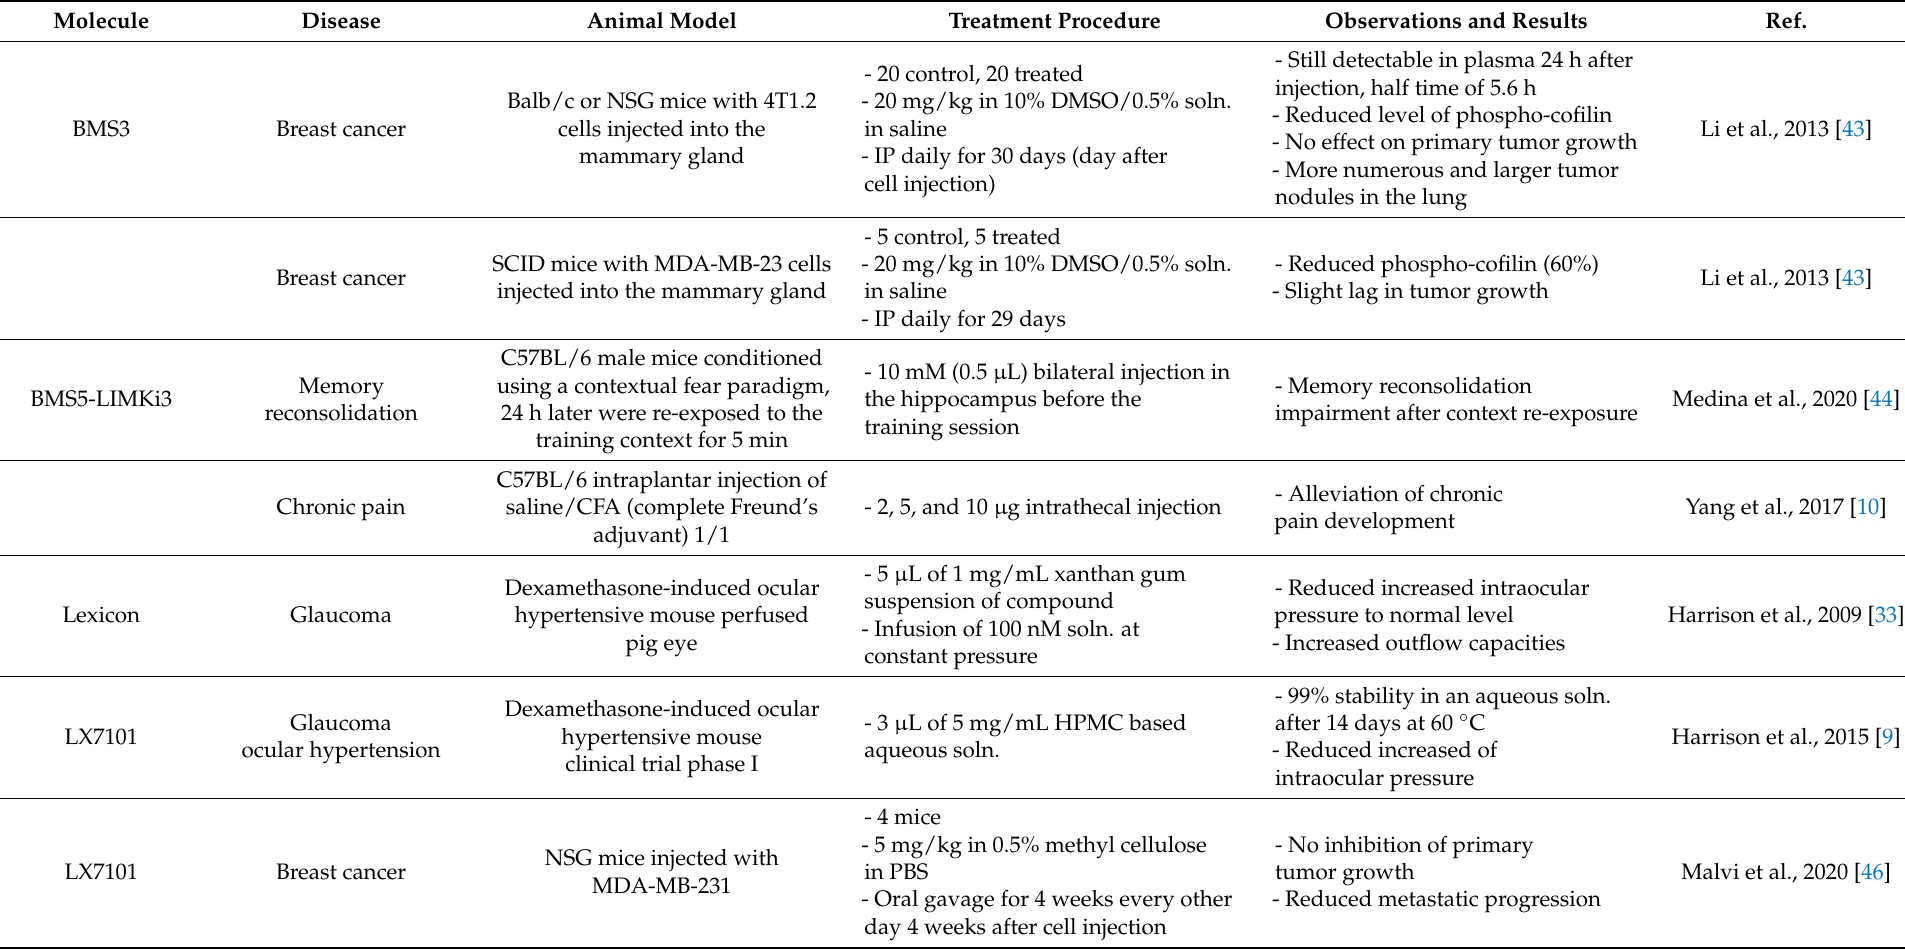
Table 3. In vivo LIMK